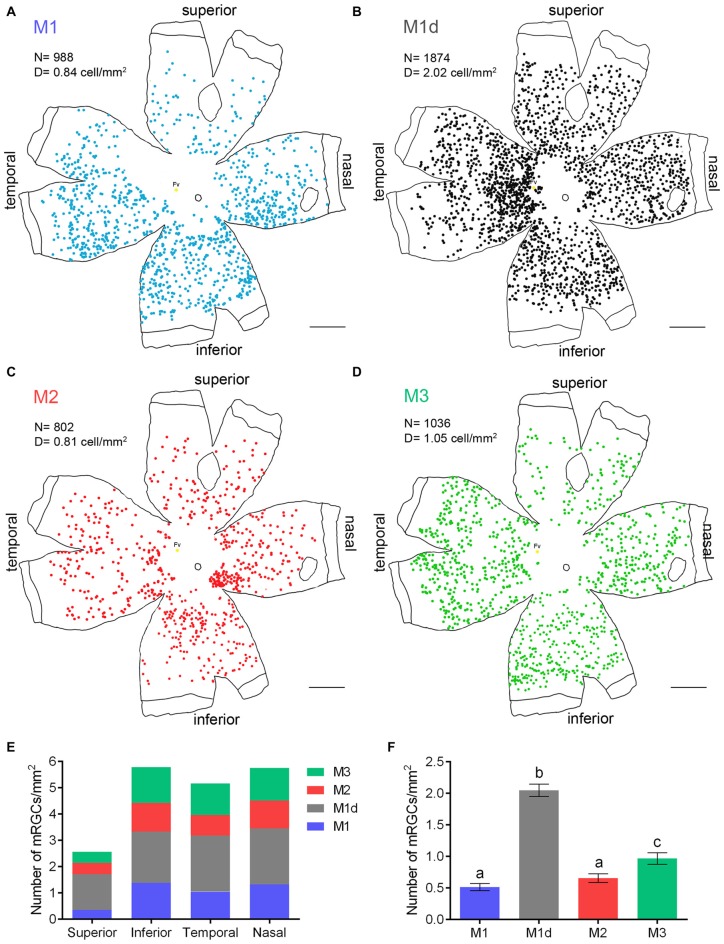
Density and distribution of the different types of human mRGCs. (A–D) Representative drawings of a 56-year-old whole-mount human retina (drawn by hand, using a camera lucida) showing the location of immunostained individual mRGCs of different types. The number of mRGCs shown in the drawings is 988 M1 (A), 1874 M1d (B), 802 M2 (C) and 1036 M3 (D) cells. (E) Density of the different types of mRGCs (cell/mm2) in different parts of the whole mount retina showed in (A–D). (F) Mean density of the different types of mRGCs (cell/mm2) in the superior-nasal part of the retina of 24 human donors aged 10–81 years. Fv, fovea; N, number of mRGCs; D, density of cells. Different letters above the histograms indicate statistical significant differences (p < 0.05). Scale bar: 5 mm.